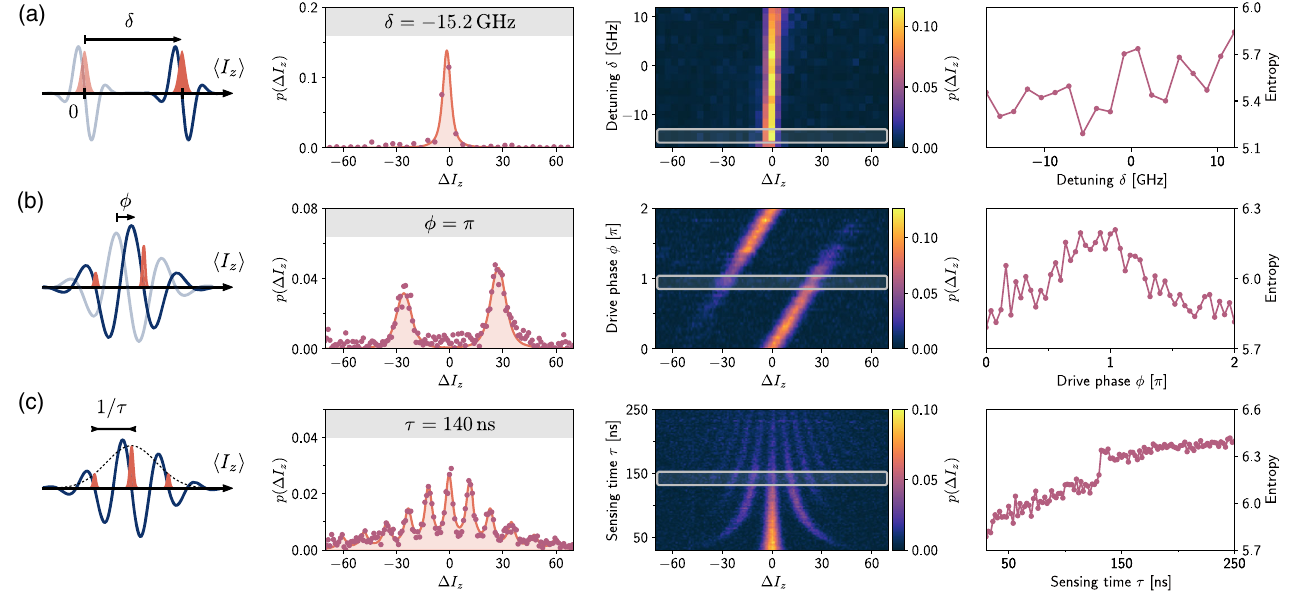
FIG. 4. Engineering spin-ensemble distributions. From left to right: sketch of how the feedback curves (solid blue) are programmed to engineer p ð I z Þ (orange shaded areas); plots of the measured probability density functions p ð A curves) at a salient point in the relevant parameter space; full experimental two-dimensional map, from which these salient slices (gray boxes) are taken, showing continuous tuning over the parameter space; information entropy S p (purple circles) of the p ð A distribution versus the relevant tuning parameter. (a) Varying δ sets the central lock point I lock z of the feedback. The extrema of the